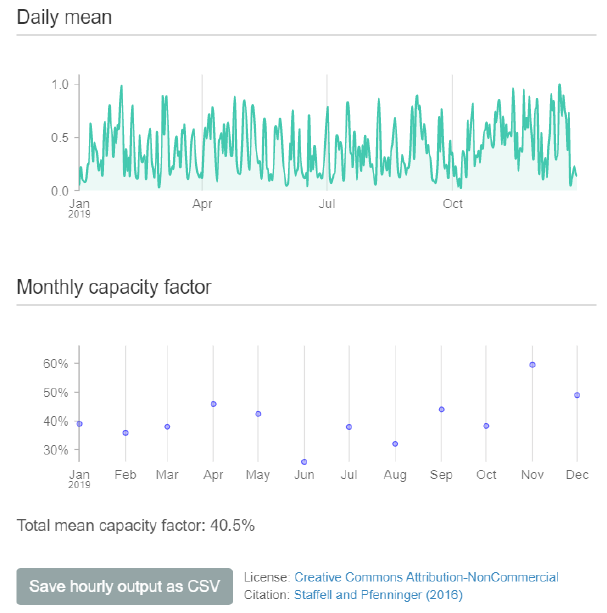
Figure 6. Simulation of power generation and capacity factor. Data source: